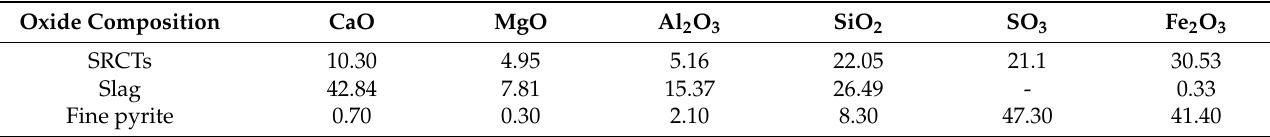
Figure 1. XRD patterns of the SRCTs ( a ) and pyrite ( b ) [26]. Table 1. Chemical compositions of SRCTs, slag, and fine pyrite